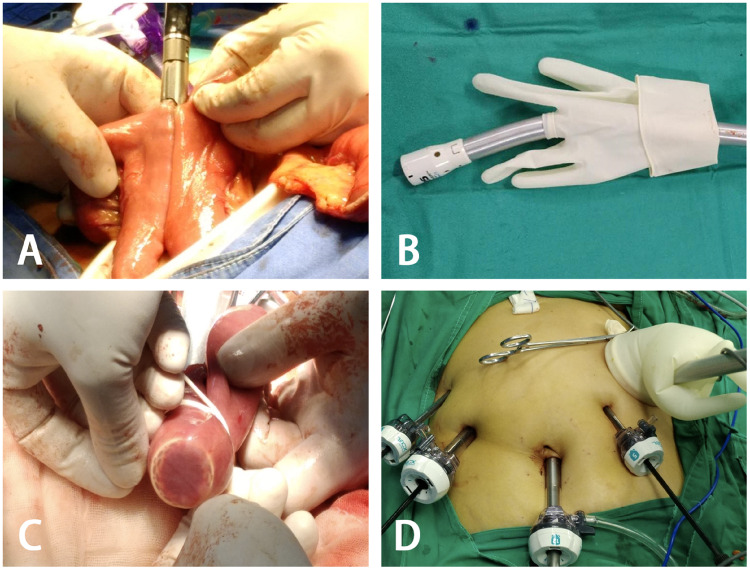
Side-to-side jejunojejunostomy and re-establishment of pneumoperitoneum to prepare for subsequent intracorporeal oesophagojejunal anastomosis. (A) A side-to-side jejunojejunostomy was performed by a linear stapler. (B) Inserting the circular stapler into a surgical glove. (C) A circular stapler was inserted into the jejunal limb and the jejunum was blinded by a rubber band. (D) Sealing off the laparotomy by a self-made single-site access system: a surgical glove attached to a circular stapler and a wound protector.